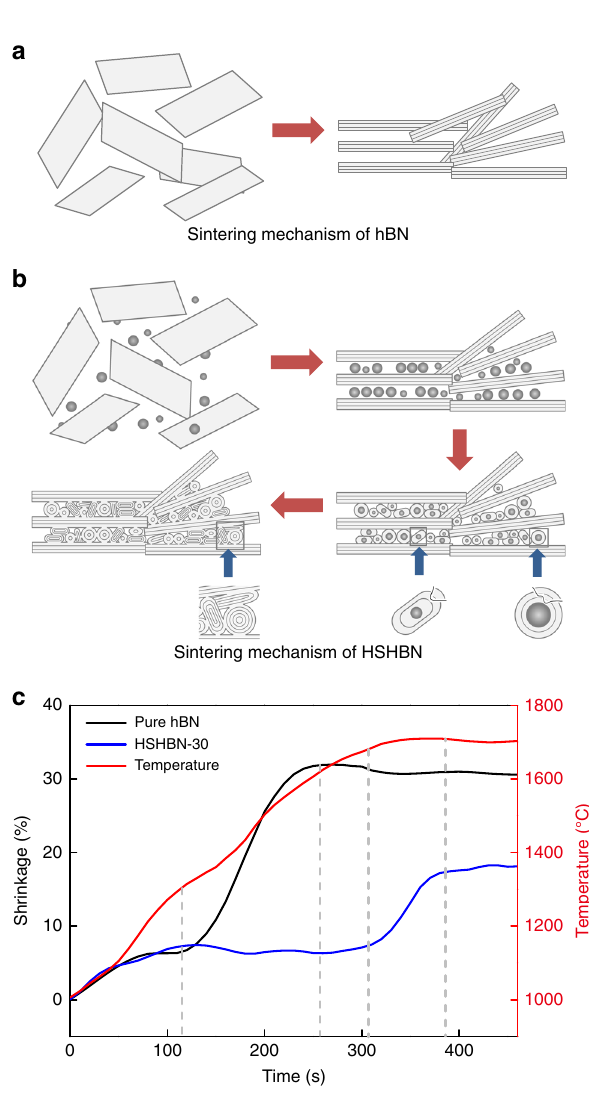
Fig. 5 Consolidation mechanisms of hBN and HSHBN during SPS. Sintering mechanisms of pure hBN ( a ) and HSHBN ( b ), and sintering shrinkage curves of pure hBN and HSHBN-30 above 1000 °C ( c